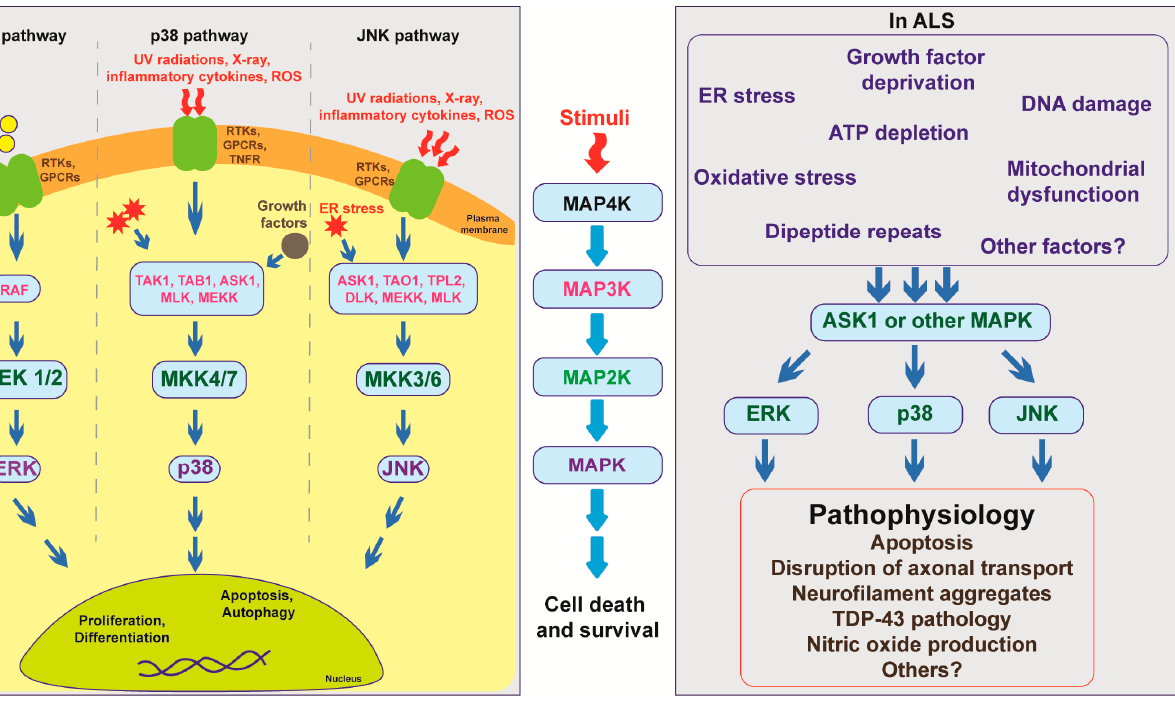
Figure 1. Overview of mitogen-activated protein kinase (MAPK) pathway showing the interaction of multiple MAPK members under normal physiological conditions and in ALS